Question: In a single sentence, describe what this figure presents.
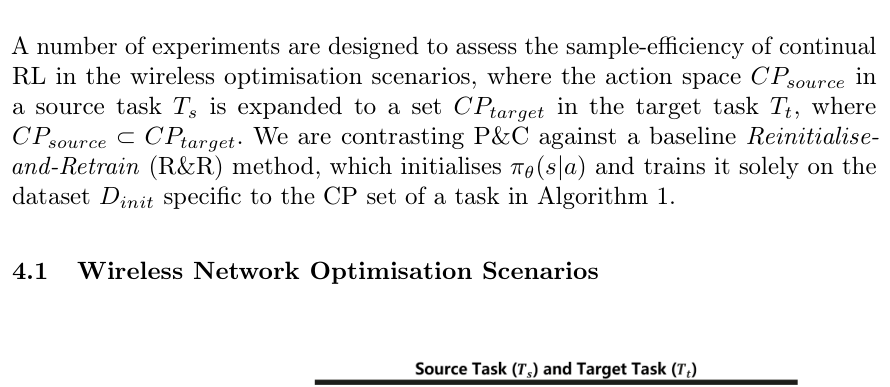
Answer: Policies trained via Reinitialise-&-Retrain (R&R) use four days of data from the target task pTtq. Policies trained via Progress-&-Compress (P&C) use two days of data from Tt (50% less), and transfer knowledge from a source task Ts.